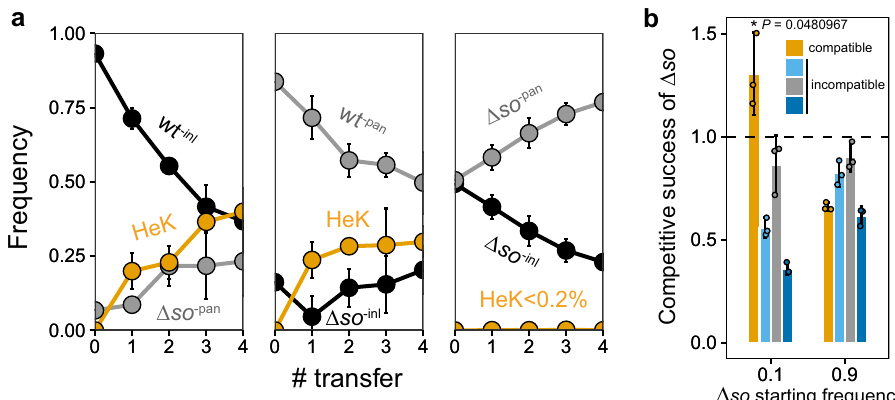
Fig. 2 The frequency of fusion between wild type and Δ so mycelia and the necessity of successful fusion for Δ so to exploit the wild type. a Fusion readily occured between wild type and Δ so ( fi rst two panels), but hardly between Δ so strains (the third panel). The fi rst two panels show the results of transfer experiments with reciprocally labeled Δ so and wild-type strains, at low starting Δ so frequency (5 – 15%), while a third panel depicts a control experiment with separately labeled Δ so mixed in a 1:1 initial ratio. The spore transfers were performed every 4 days with 1% of total spores. The frequency of genotypes was calculated using phenotype counts at every transfer on non-supplemented plates and supplemented with inositol or pantothenic acid. inl -de fi cient and pan -de fi cient strains are indicated in black and gray, respectively. The orange line shows the frequency of heterokaryons (HeK). b Competition experiments between Δ so and compatible (orange bars) and three nearly-isogenic incompatible wild-type strains at two starting frequencies of Δ so (10 and 90%). Δ so frequency only increased when grown with a compatible competitor and only at low frequencies (asterisk marks signi fi cant difference of P < 0.05; one-tailed Student ’ s t -test, t -value = 2.986799, df = 2, P = 0.0480968). The competitive success of Δ so was measured by qPCR. In both panels, error bars are 95% con fi dence intervals around means calculated from three biological replicates. The replicate data points are overlaid as dots. Source data are provided as a Source Data fi